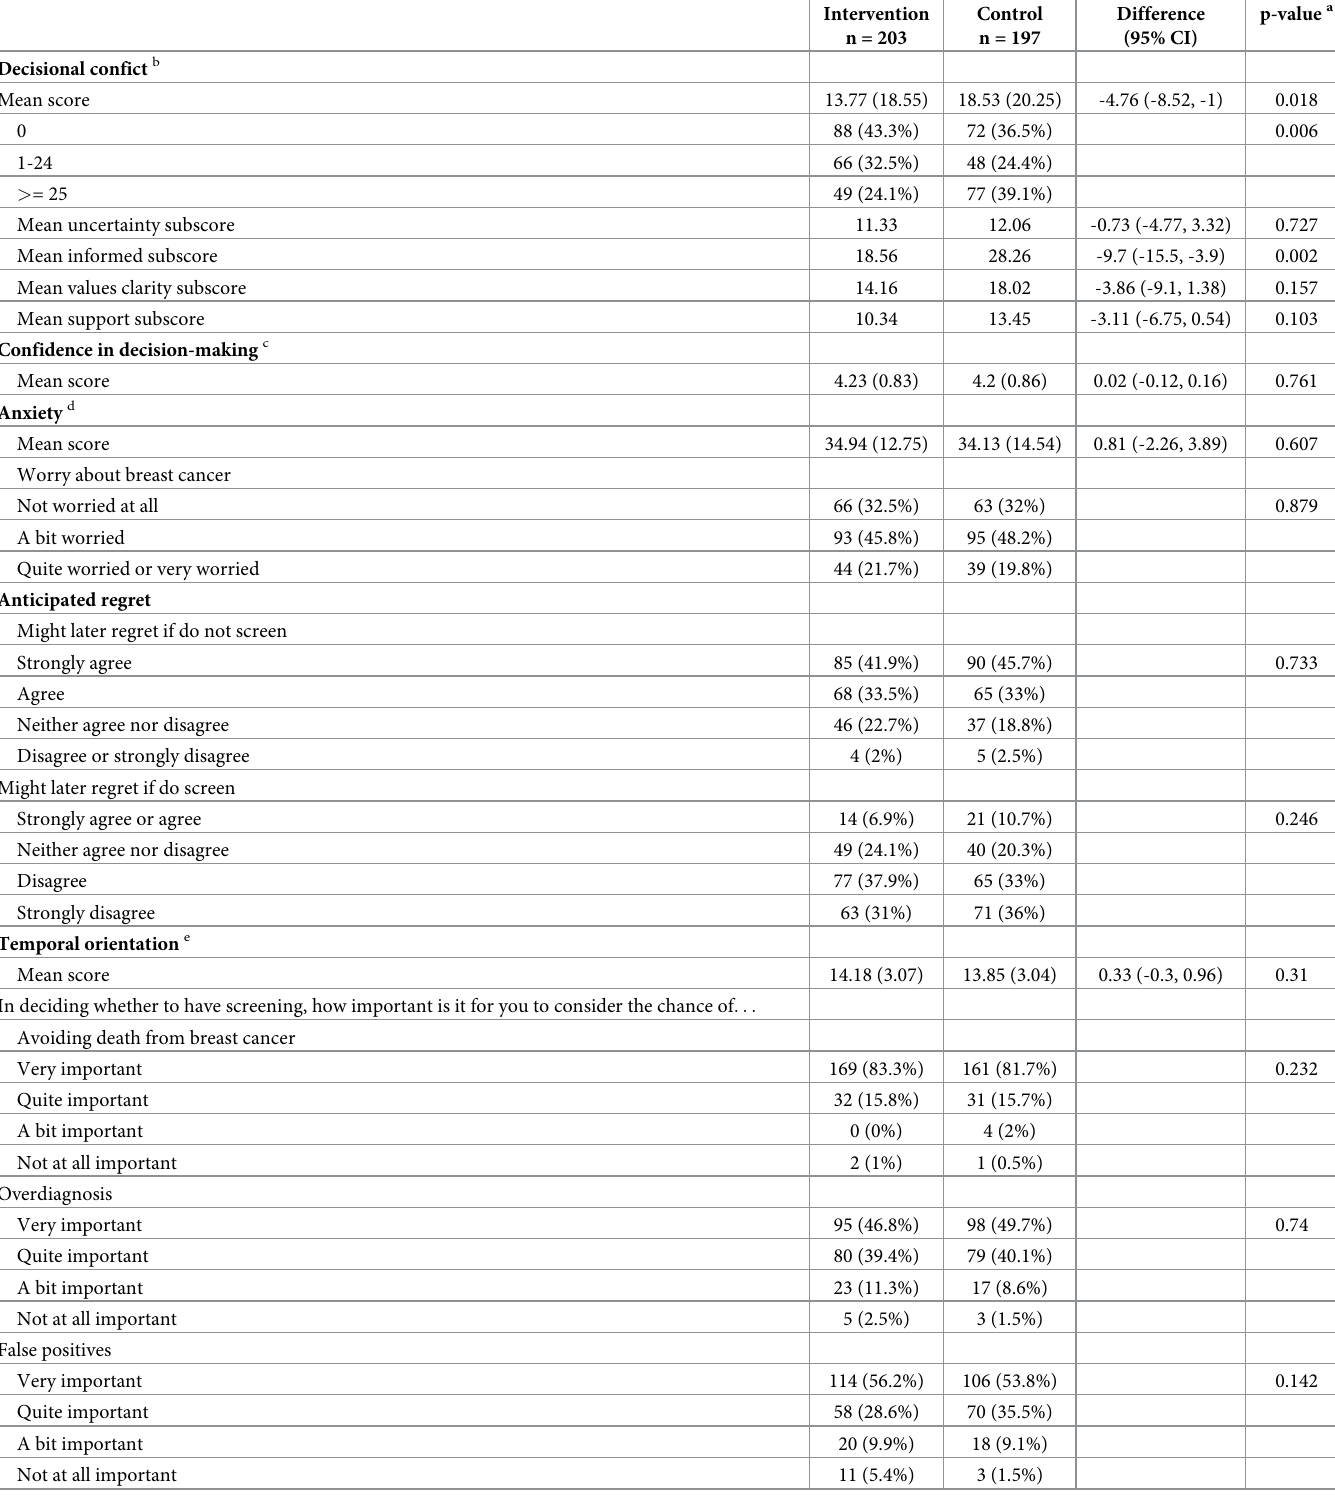
Table 4. Analysis of secondary